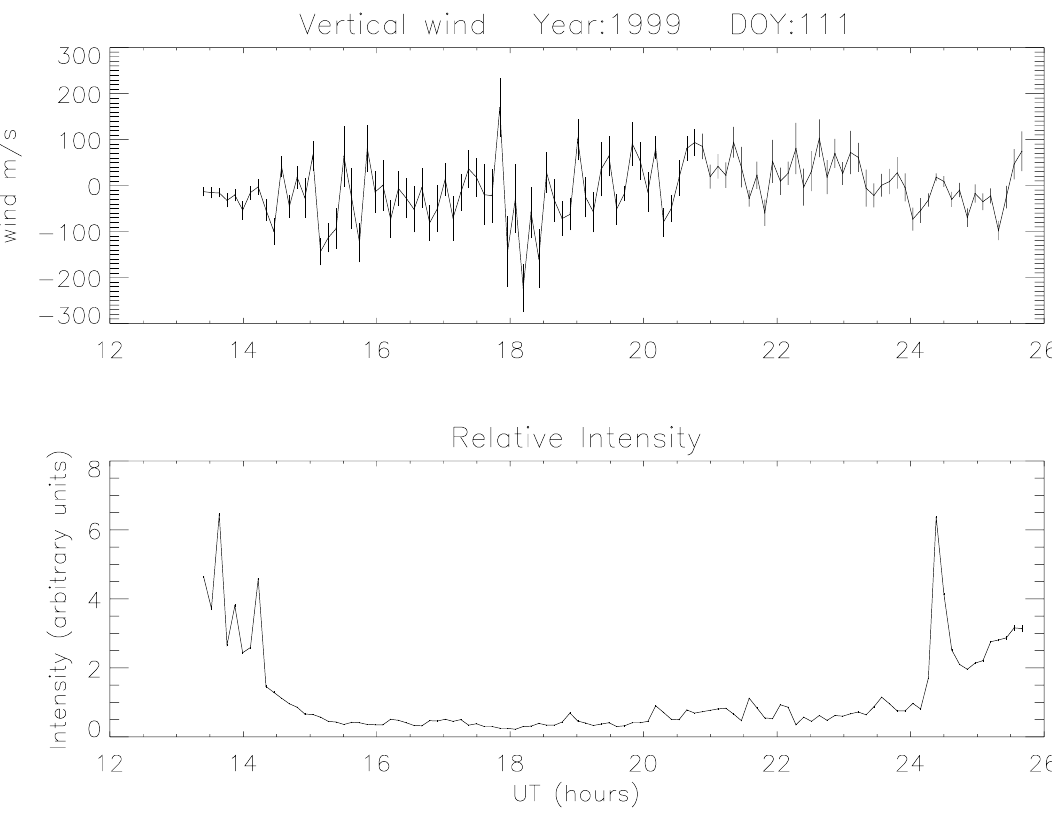
Fig. 2. FPS λ 630 nm data of wind and relative intensity from DoY